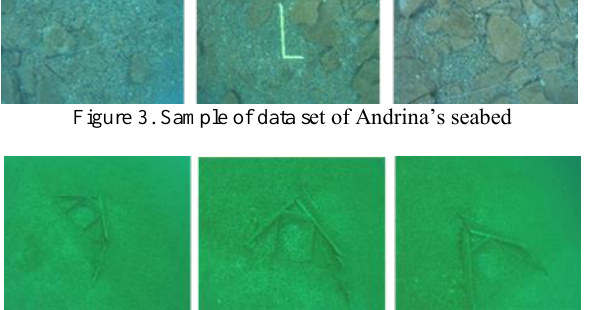
Figure 4. Sample of data set of small boat’s section